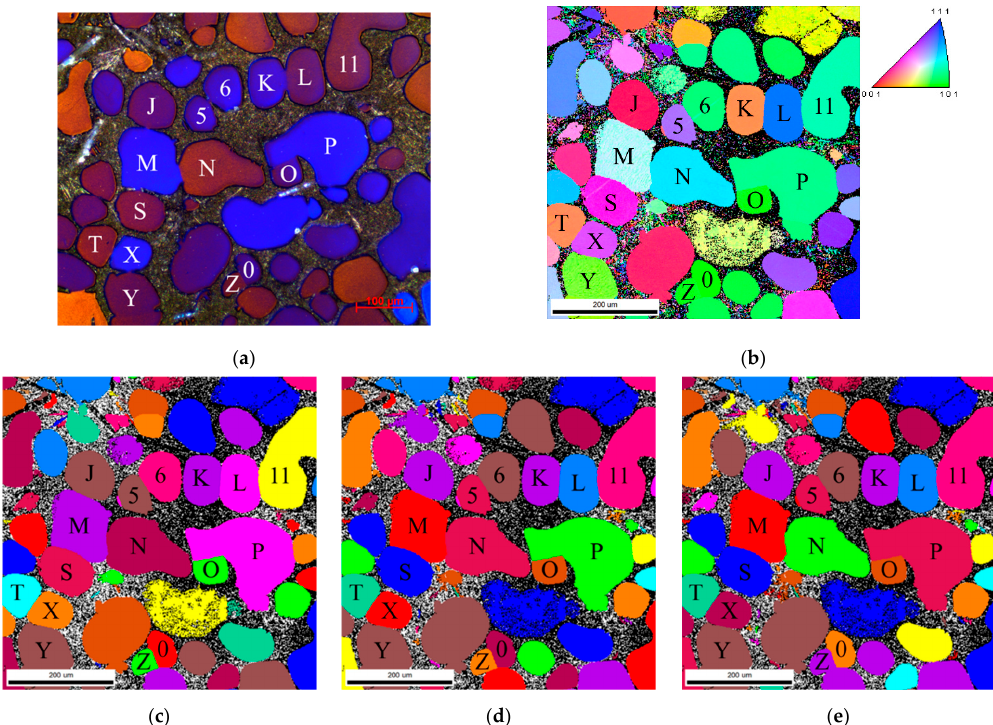
Figure 4. Thixocast sample, copper mold, poured at 630 °C; ( a ) polarized light image with sensitive tint plate, polished and anodized with Barker’s reagent, ( b ) inverse pole figure (IPF) map, ( c ) 5° grain map, ( d ) 10° grain map, ( e ) 15° grain map.